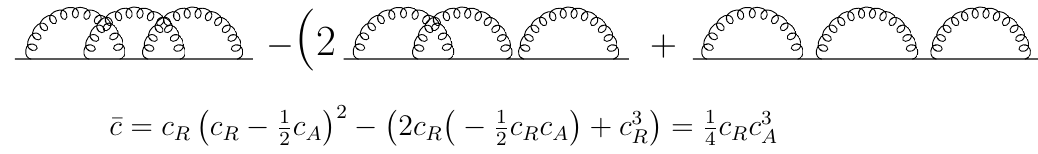
Figure 3. Example of the determination of the modi(cid:12)ed color factor. The modi(cid:12)ed color factor of this connected diagrams with three gluons is obtained by considering the usual color factor and subtracting the color factor of all possible